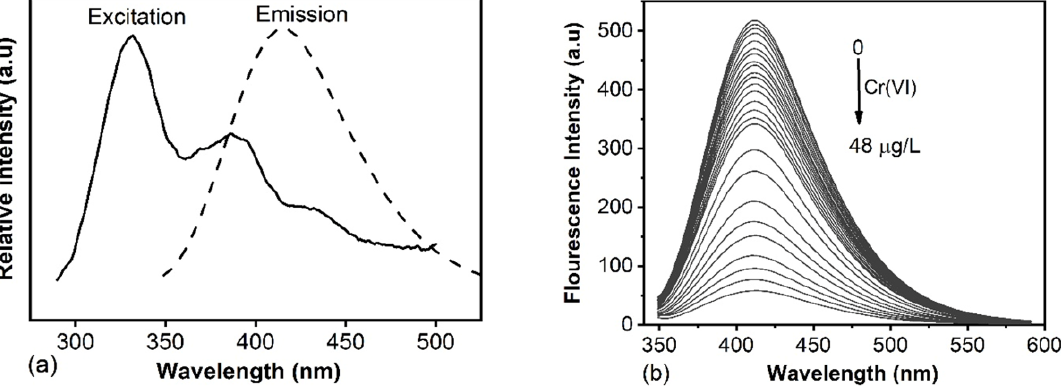
Figure 4. ( a ) Excitation and emission wavelengths of the synthesized particles and ( b ) fluorescence quenching spectra of N,Zn-doped fluorescent carbon dots as a function of different concentrations of Cr(VI). Excitation was performed at 330 nm. Cr(VI). Excitation was performed at 330